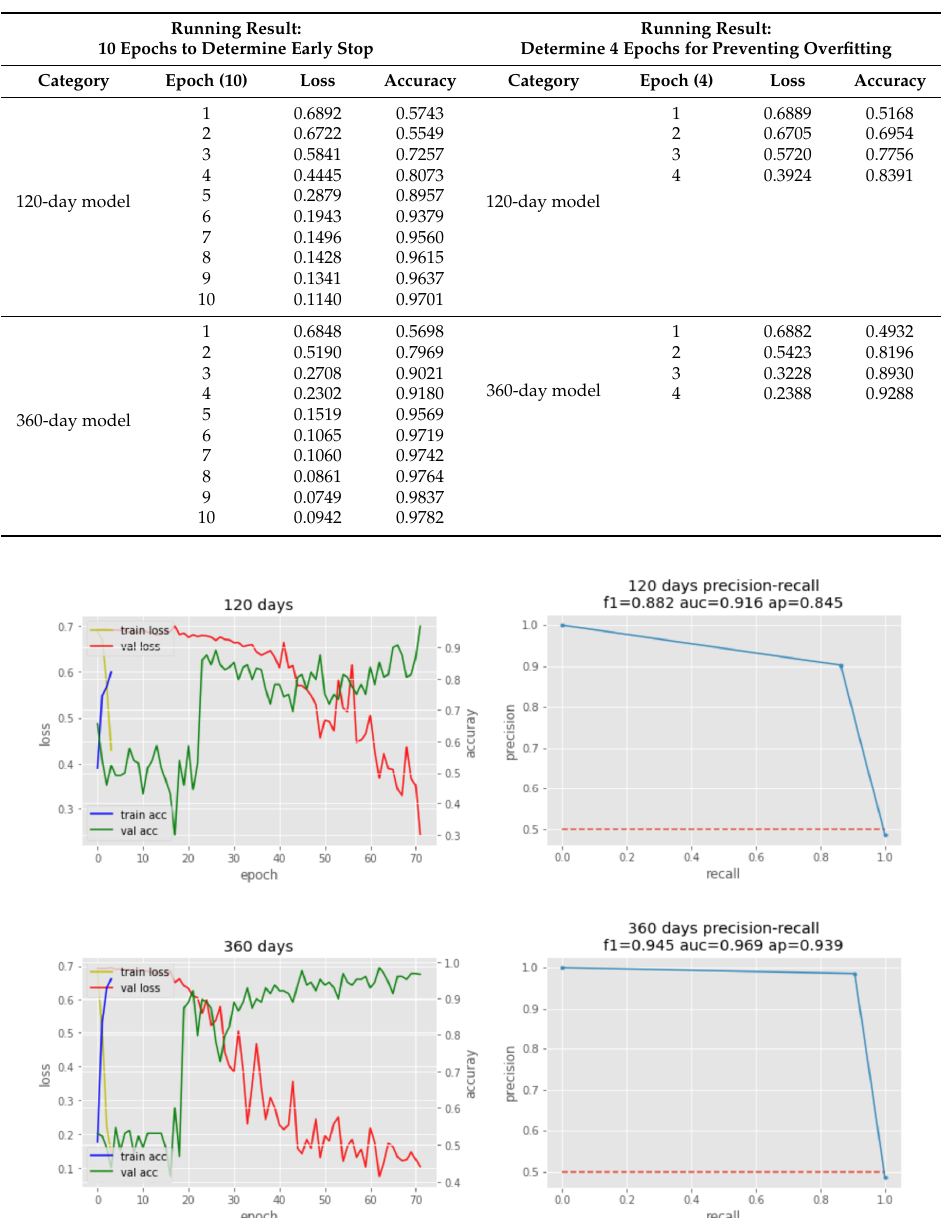
Table 2. Determining epochs to build model.